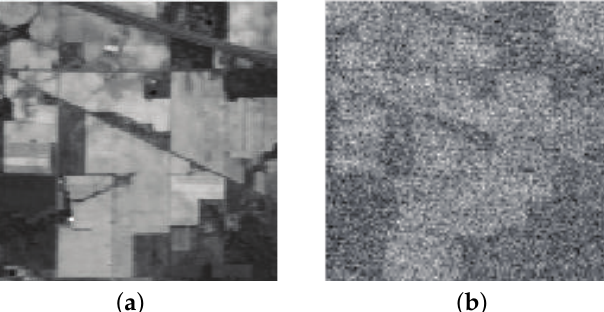
Figure 4. Grayscale image of Indian pines: ( a ) Grayscale image of the 120-th band; ( b ) grayscale image of the 200-th band.